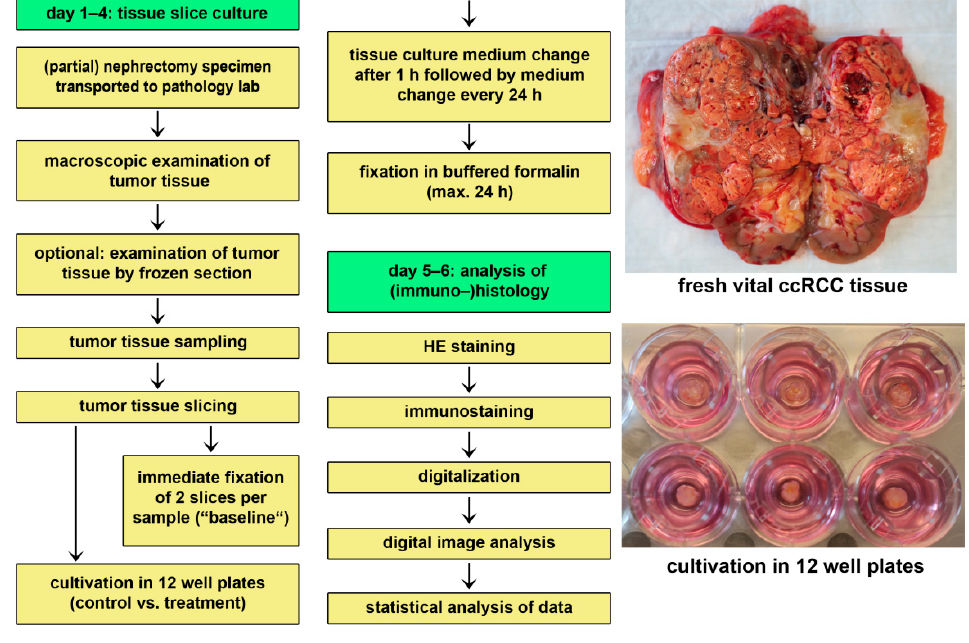
Figure 1. Tissue culture workflow.